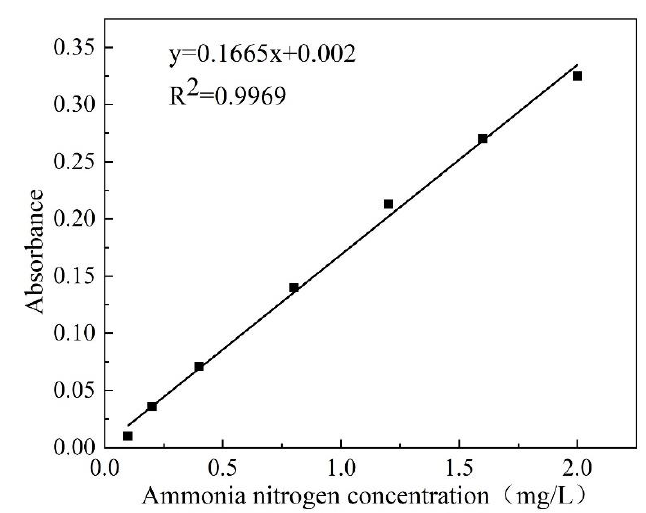
Figure 3. Standard curve.